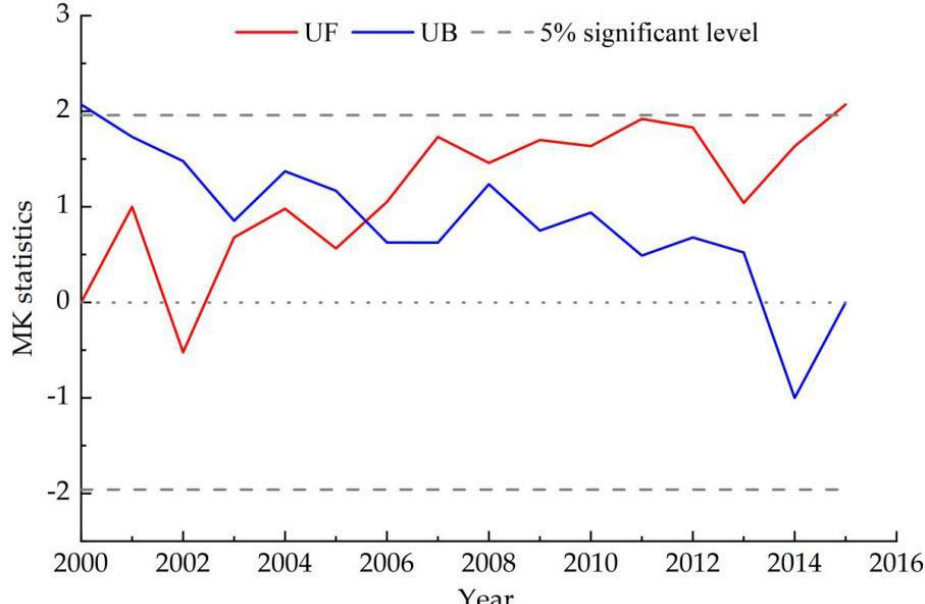
Figure 5. The M-K statistics of annual average SM in the Yellow River Basin from 2000 to 2015.